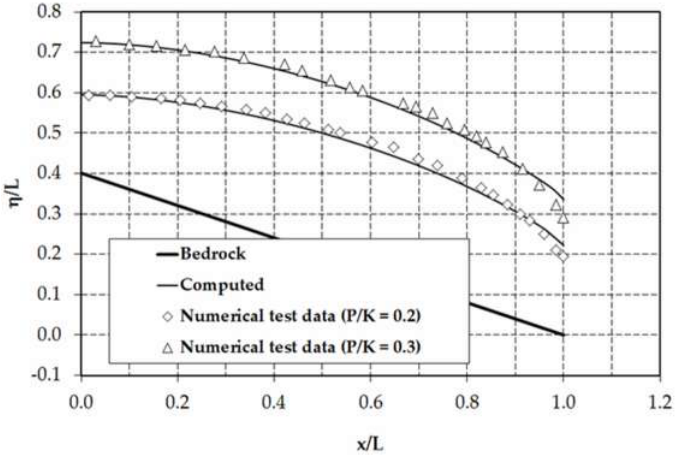
Figure 7. Recharge-induced unconfined groundwater flows in a sloping aquifer (bedrock slope = 21.8°).